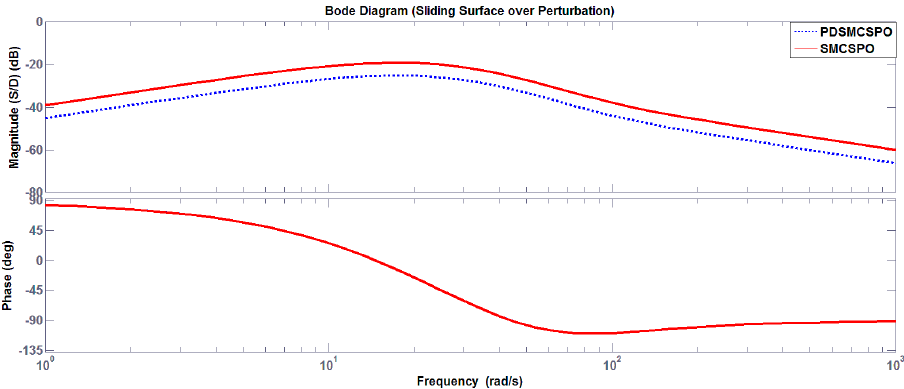
Figure 4. Bode plot of sliding surface over perturbation.